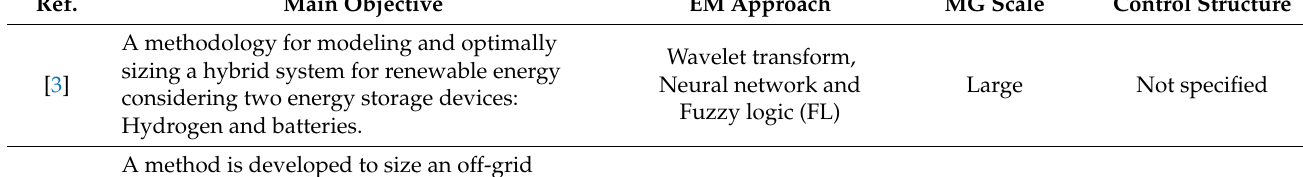
Table 2. Survey through collection of EM for the hybrid MG